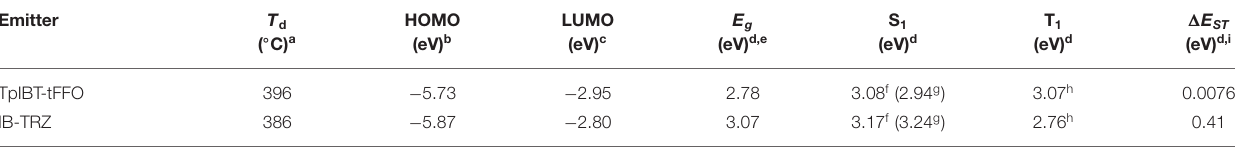
TABLE 2 | Experimentally obtained thermal properties, energy levels of HOMO, LUMO, E g , S 1 , T 1 , and 1 E ST for TpIBT-tFFO and IB-TRZ.